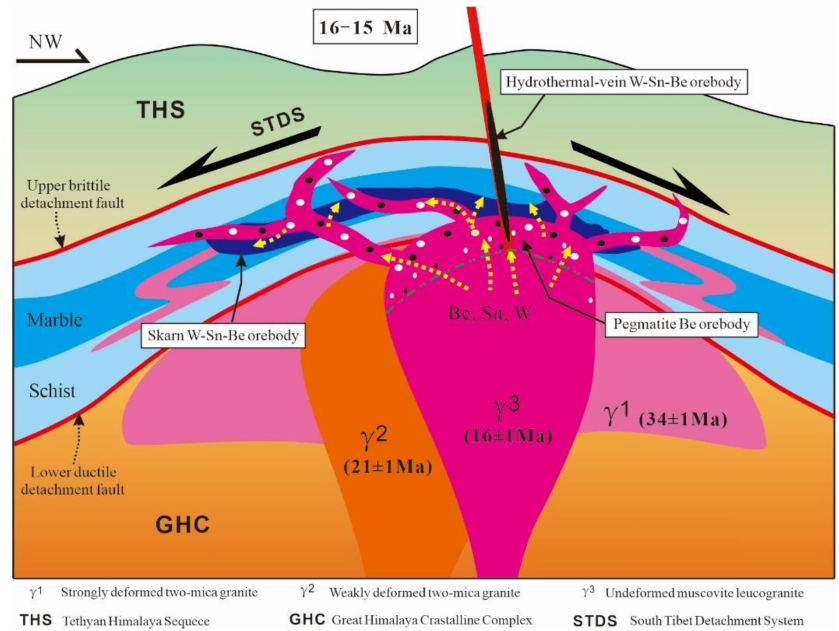
Figure 12. Metallogenic model of the Cuonadong deposit, Tibet (after